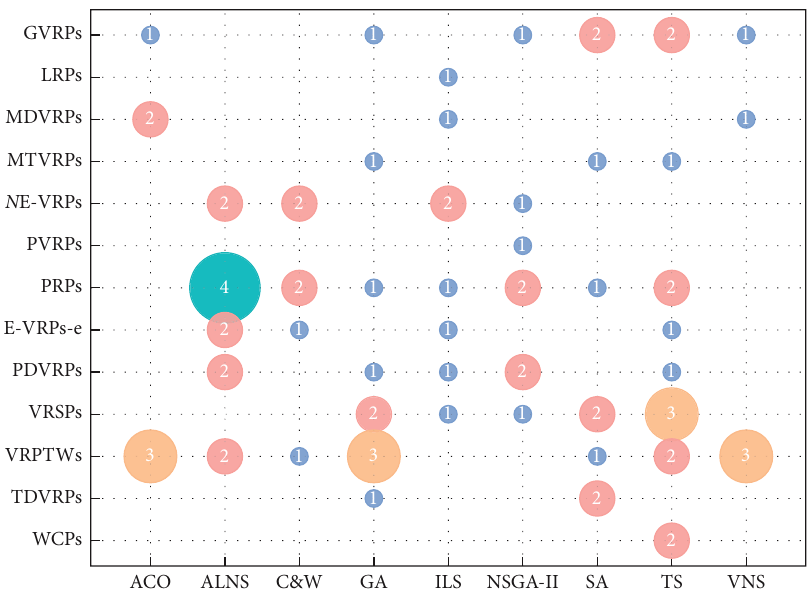
Figure 4: Bubble chart shows how many times a method has been used to solve GVRPs. Note that one method can be used to solve different variants.